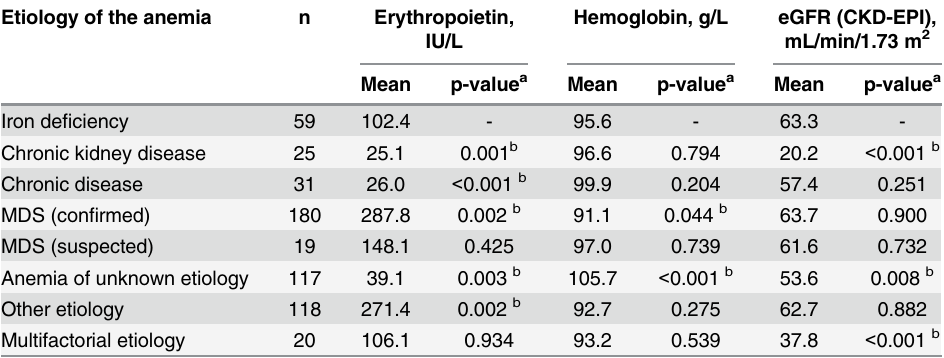
Table 2. EPO, hemoglobin and eGFR for each category of anemia etiology compared to iron defi- ciency anemia. Etiology of the anemia n Erythropoietin, Hemoglobin, g/L eGFR (CKD-EPI), IU/L mL/min/1.73 m 2 Mean p-value a Mean p-value a Mean p-value a Iron de fi ciency 59 102.4 - 95.6 - 63.3 - Chronic kidney disease 25 25.1 0.001 b 96.6 0.794 20.2 < 0.001 b Chronic disease 31 26.0 < 0.001 b 99.9 0.204 57.4 0.251 MDS (con fi rmed) 180 287.8 0.002 b 91.1 0.044 b 63.7 0.900 MDS (suspected) 19 148.1 0.425 97.0 0.739 61.6 0.732 Anemia of unknown etiology 117 39.1 0.003 b 105.7 < 0.001 b 53.6 0.008 b Other etiology 118 271.4 0.002 b 92.7 0.275 62.7 0.882 Multifactorial etiology 20 106.1 0.934 93.2 0.539 37.8 < 0.001 b a The p-value is calculated using an unpaired t-test comparison against iron de fi ciency b p <